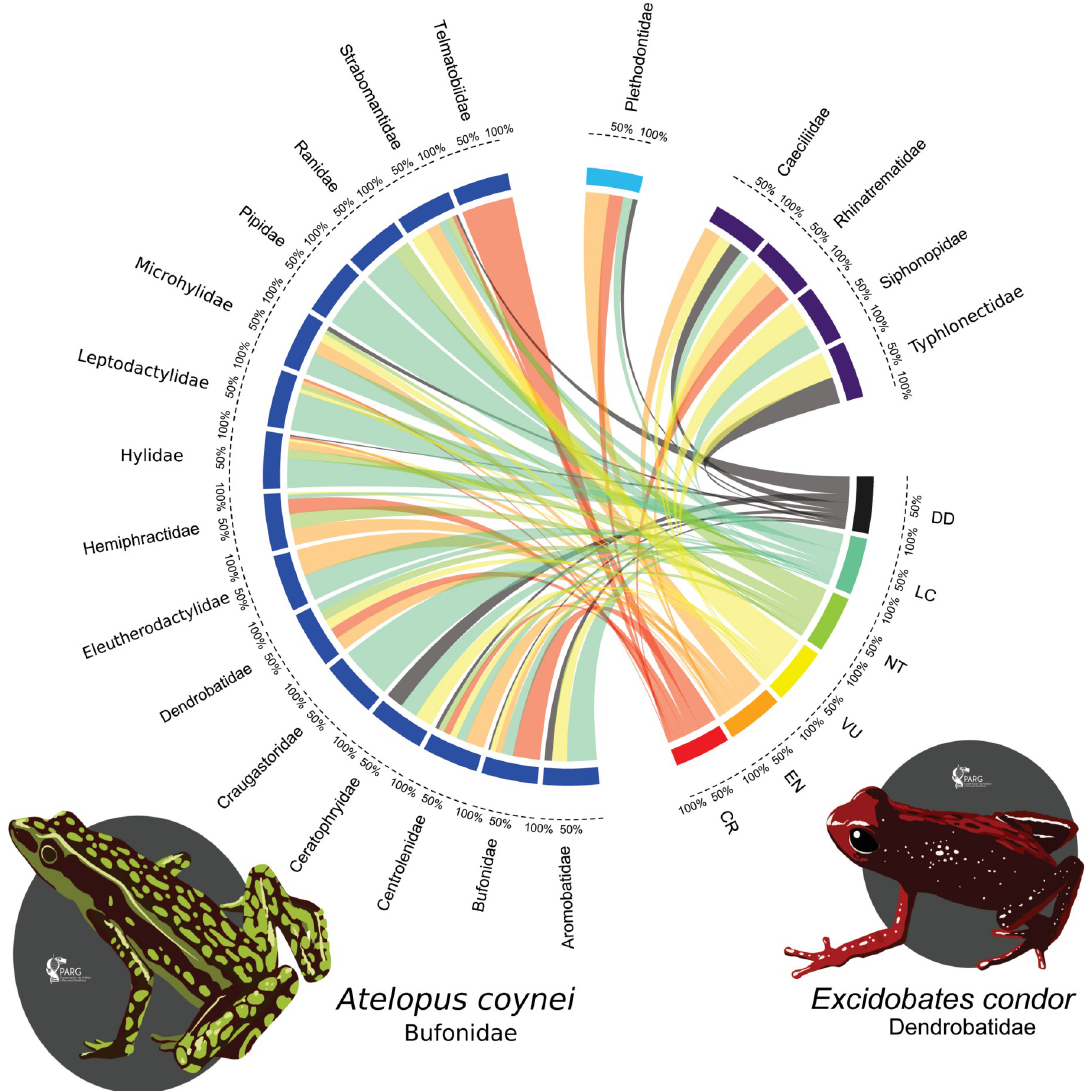
Fig 3. A taxonomic perspective of the Red List status of amphibians in Ecuador. The species composition (% of threatened species) of each family in Anura (dark blue), Caudata (bright blue), and Gymnophiona (purple) is characterized by ribbons connected to the current Red List status for each species. The numerical values below each family name depict the relative percentage with the associated Red List category: CR = Critically Endangered, EN = Endangered, VU = Vulnerable, NT = Near Threatened, LC = Least Concern, and DD = Data Deficient. Two endemic and threatened frogs are illustrated by Atelopus coynei (Critically endangered) distributed in northern Andes of Ecuador, whereas Excidobates condor (Endangered) is distributed in the Cordillera del Condor, southeastern Ecuador. Both species are threatened by habitat loss, mining, and climate change. Illustrations by